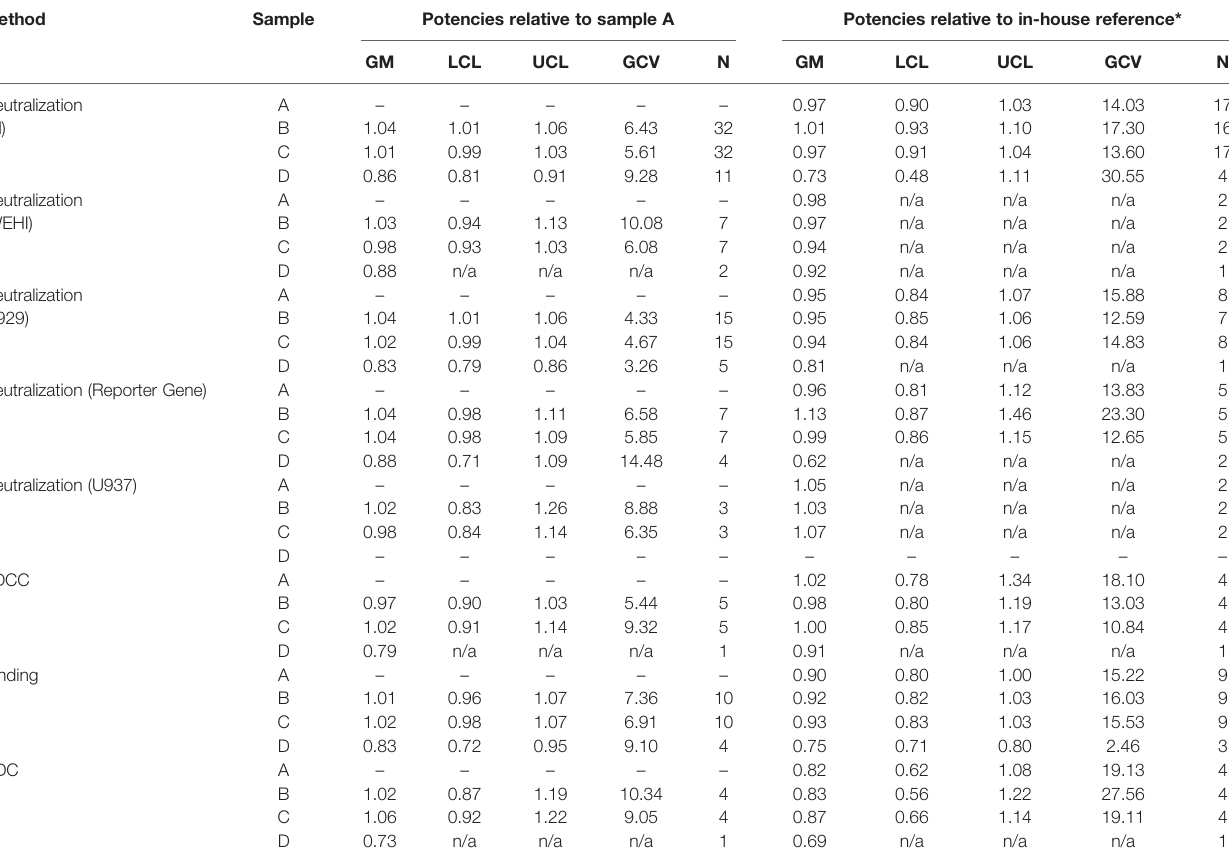
TABLE 6 | Overall geometric mean relative potency estimates for all assays contributed to the study.